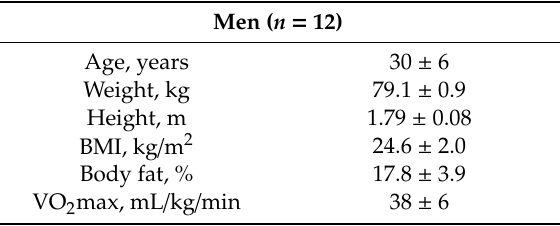
Table 1. Baseline subject characteristics 1